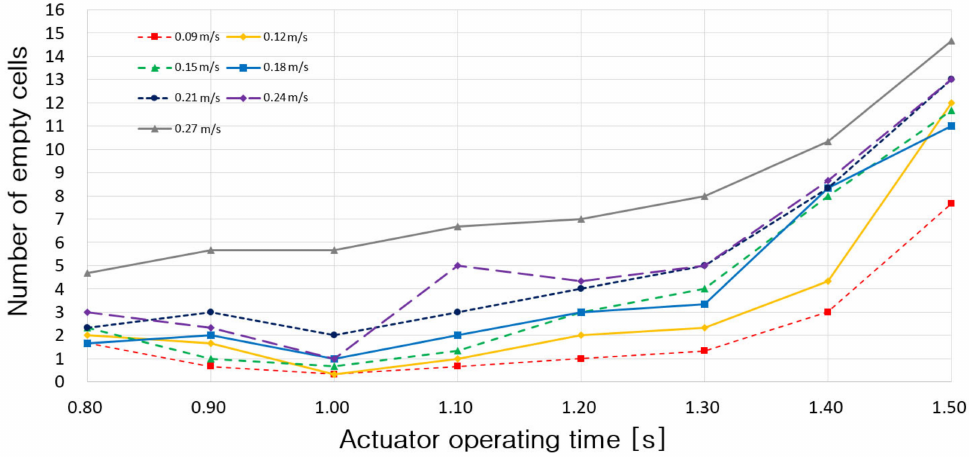
Figure 18. Number of empty cells according to pneumatic-type actuator operating time.